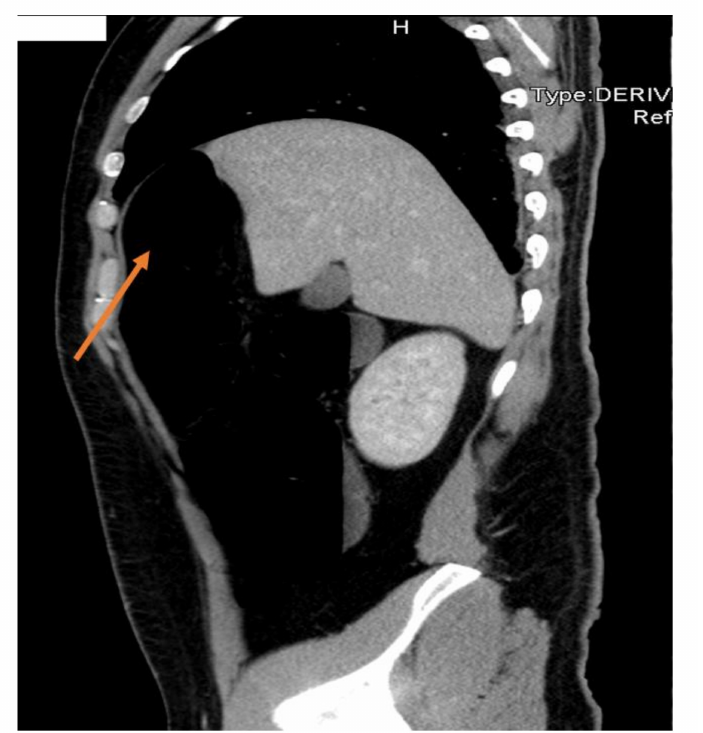
Figure 3. Sagittal computed tomography scan showing distended large bowel anterior to the liver (orange